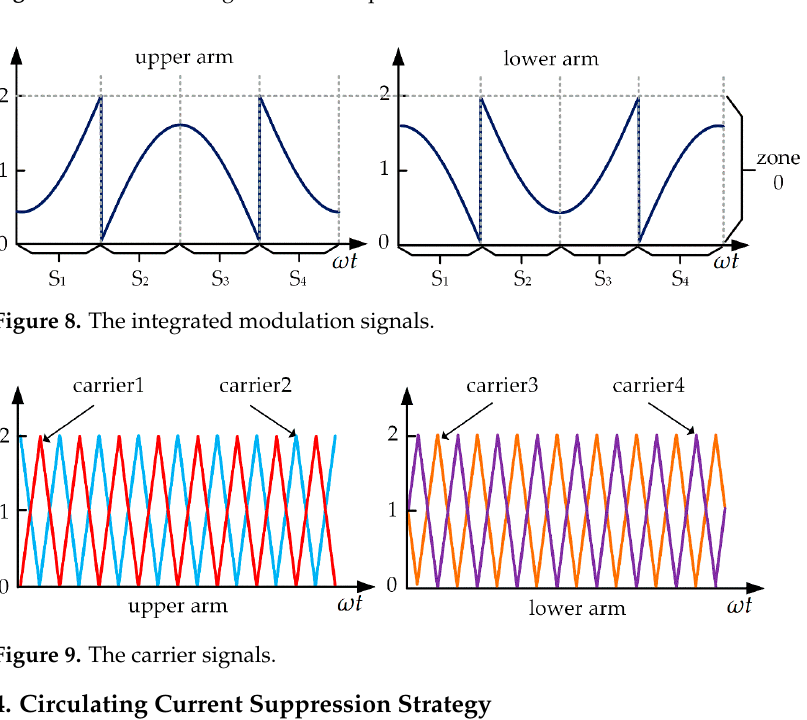
Figure 7. The block diagram of the improved modulation method.